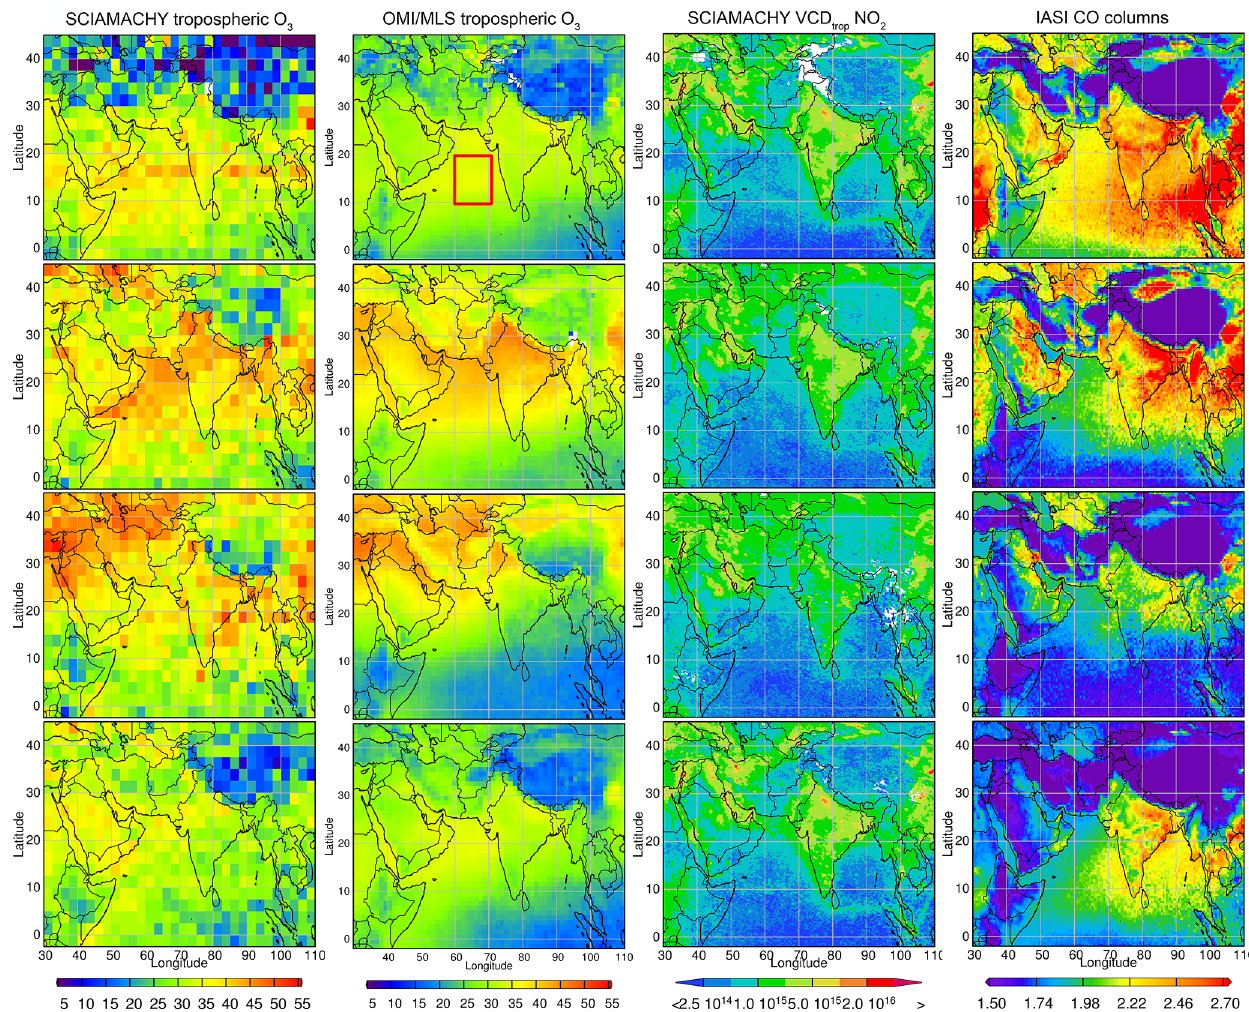
Figure 2. Plots of the TOC and NO 2 (Hilboll et al., 2013) and CO ( × 10 18 ; George et al., 2009) as a function of season in 2008. The unit for TOC is DU and that for NO 2 and CO in moleccm − 2 . From top to bottom are DJF (December to February), MAM (March to May), JJA (June to August) and SON (September to